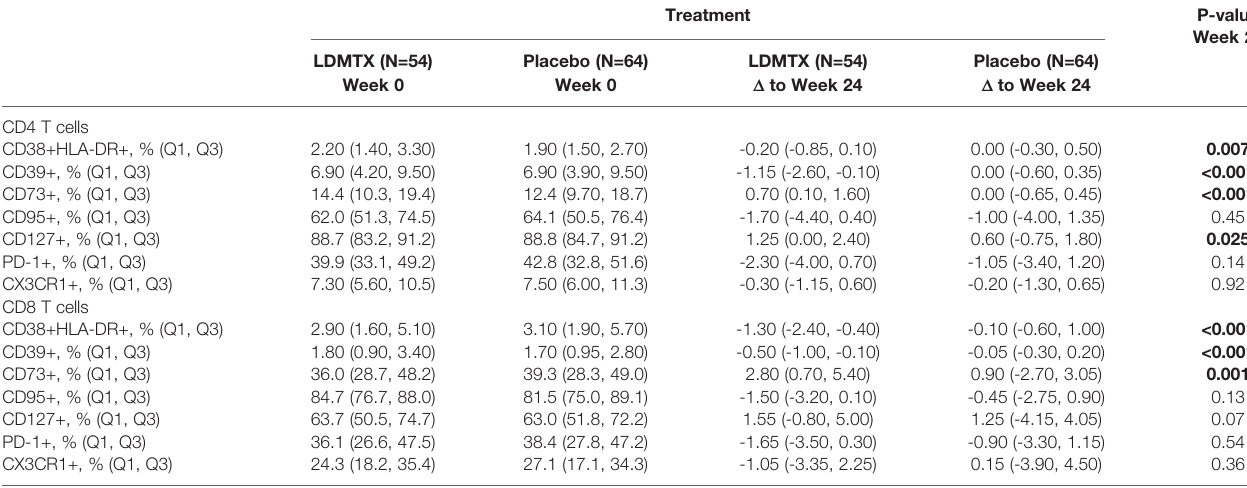
TABLE 2 | Changes from baseline in T cell activation